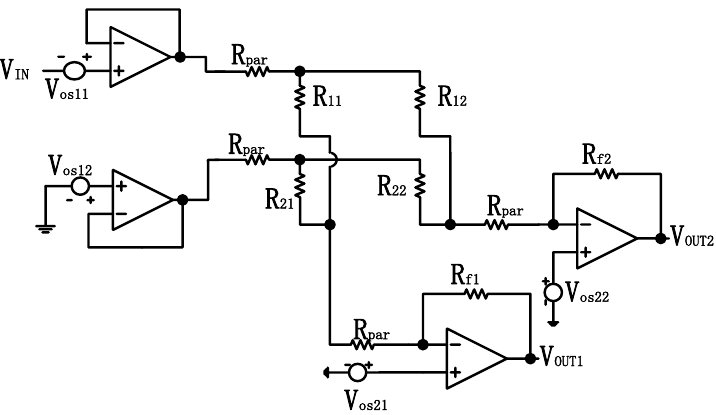
Figure A3. A 2 × 2 array circuit model including parasitic and crosstalk current effects for ZPM. To calculate the intrinsic crosstalk current effect, we first extract the array network and apply Kirchhoff’s law, as shown in Figure A4 and Equation